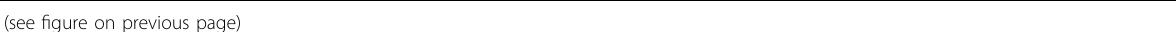
Fig. 1 Chemoresistance in A431 cells is dependent on RCP and mutant p53 expression. A Resazurin survival assay of two different ctr A431 cells, two different p53 KO cells and RCP KO A431 cells in response to increasing doses of cisplatin and etoposide, measured after 96 h. Statistical differences were measured using a paired two-way ANOVA corrected for multiple testing (two-sided) and IC50 values were measured using a linear regression analysis. IC50 and P -values can be found in Supplemental Tables 1 and 2. Error bars indicate SD of average values of three independent experiments with three technical repeats each. Western blot panels are shown on the right incubated for RCP, p53 and GAPDH as loading control. B Resazurin survival assay of ctr, p53 KO cells and RCP KO A431 cells that were selected for GFP or GFP-RCP expression upon transfection. Survival was measured 72 h after increasing doses of cisplatin of etoposide, measured after 96 h. Statistical differences were measured using a paired two-way ANOVA corrected for multiple testing (two-sided) and IC50 values were measured using a linear regression analysis. IC50 and P -values can be found in Supplemental Tables 3 and 4. Error bars indicate SD of average values of three independent experiments with three technical repeats each. GFP-RCP expression was veri fi ed using western blot (right panels) using RCP and GAPDH as loading control. C A431 ctr1 and ctr2, p53 KO and RCP KO cells were treated with increasing amounts of cisplatin (top) or etoposide (bottom), allowed to grow in colonies (left panel) and quanti fi ed (right panel). Statistical differences were measured using a paired two-way ANOVA corrected for multiple testing (2-sided). P -values can be found in Supplemental Table 5. Error bars indicate SD of average values of three independent experiments with three technical repeats each. D Immuno fl uorescence and confocal imaging of cleaved caspase 3 (CC3) in A431 ctr1 and ctr2, RCP KO and p53 KO cells upon treatment with cisplatin for 48 h (4 µM). Automated quanti fi cation of CC3 staining per DAPI measured using fl uorescence microscopy is shown on the right in a box and whiskers plot, with mean values indicated. Error bars indicate SD of three independent experiments. * Indicates statistical signi fi cance tested using a t -test, two-sided P < 0.0001 for